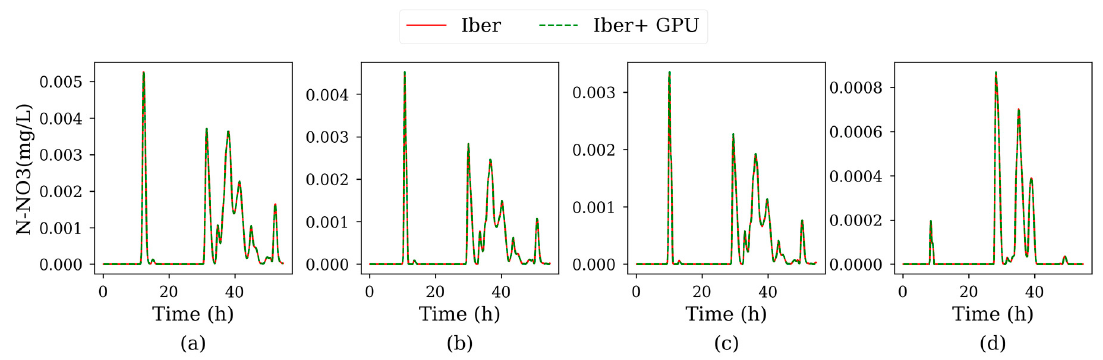
Figure A5. Time series of nitrate-nitrite nitrogen for Test 3, sampled at control points P1 ( a ), P2 ( b ), P3 Figure A5. Time series of nitrate ‐ nitrite nitrogen for Test 3, sampled at control points P1 ( a ), P2 ( b ), Figure A5. Time series of nitrate ‐ nitrite nitrogen for Test 3, sampled at control points P1 ( a ), P2 ( b ), Figure A5. Time series of nitrate ‐ nitrite nitrogen for Test 3, sampled at control points P1 ( a ), P2 ( b ), ( c ) and P4 ( d ). P3 ( c ) and P4 ( d ). P3 ( c ) and P4 ( d ). P3 ( c ) and P4 ( d ).